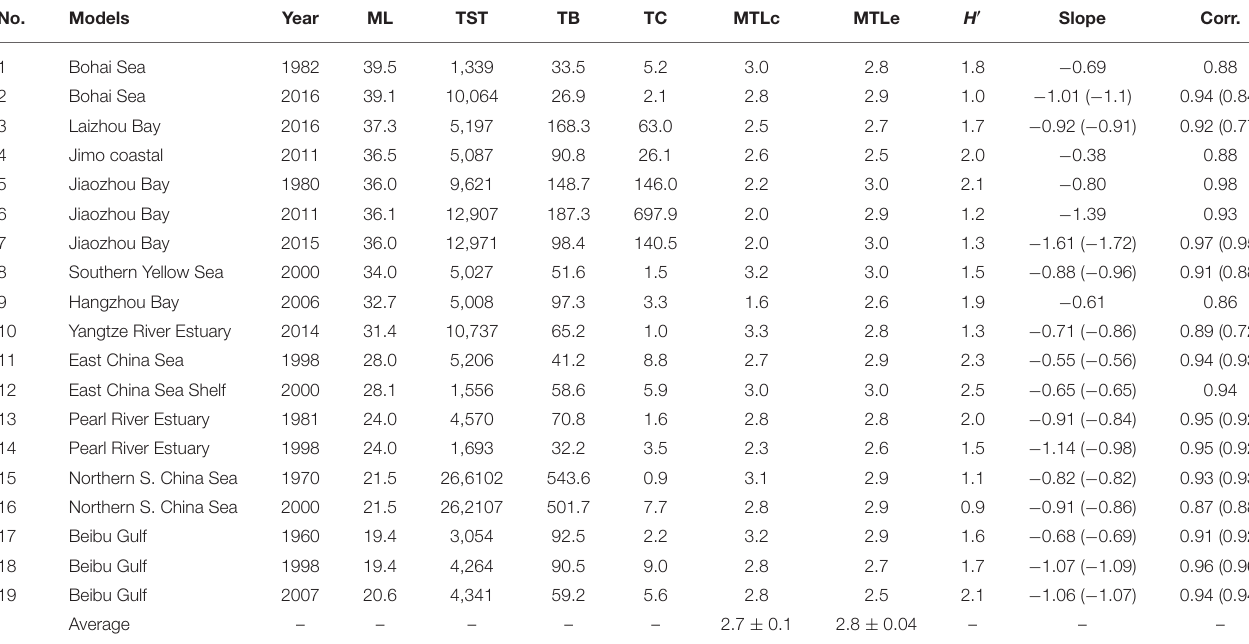
TABLE 2 | Indices and values of models examined in China’s seas from 1960s to